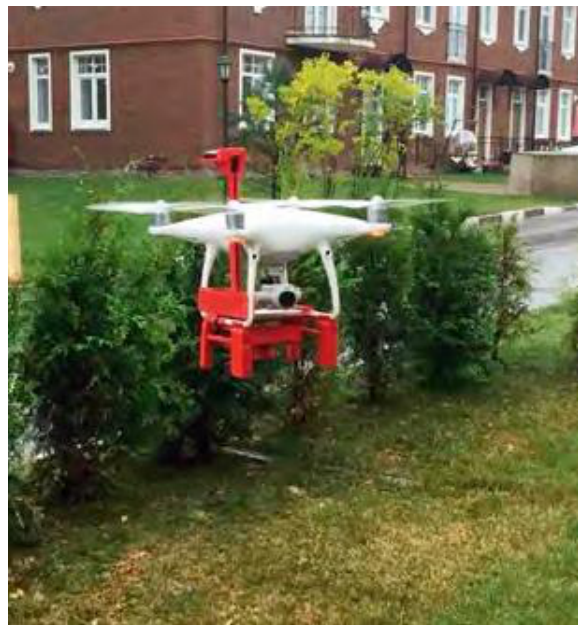
Figure 15. Special suspension for RedEdge multispectral